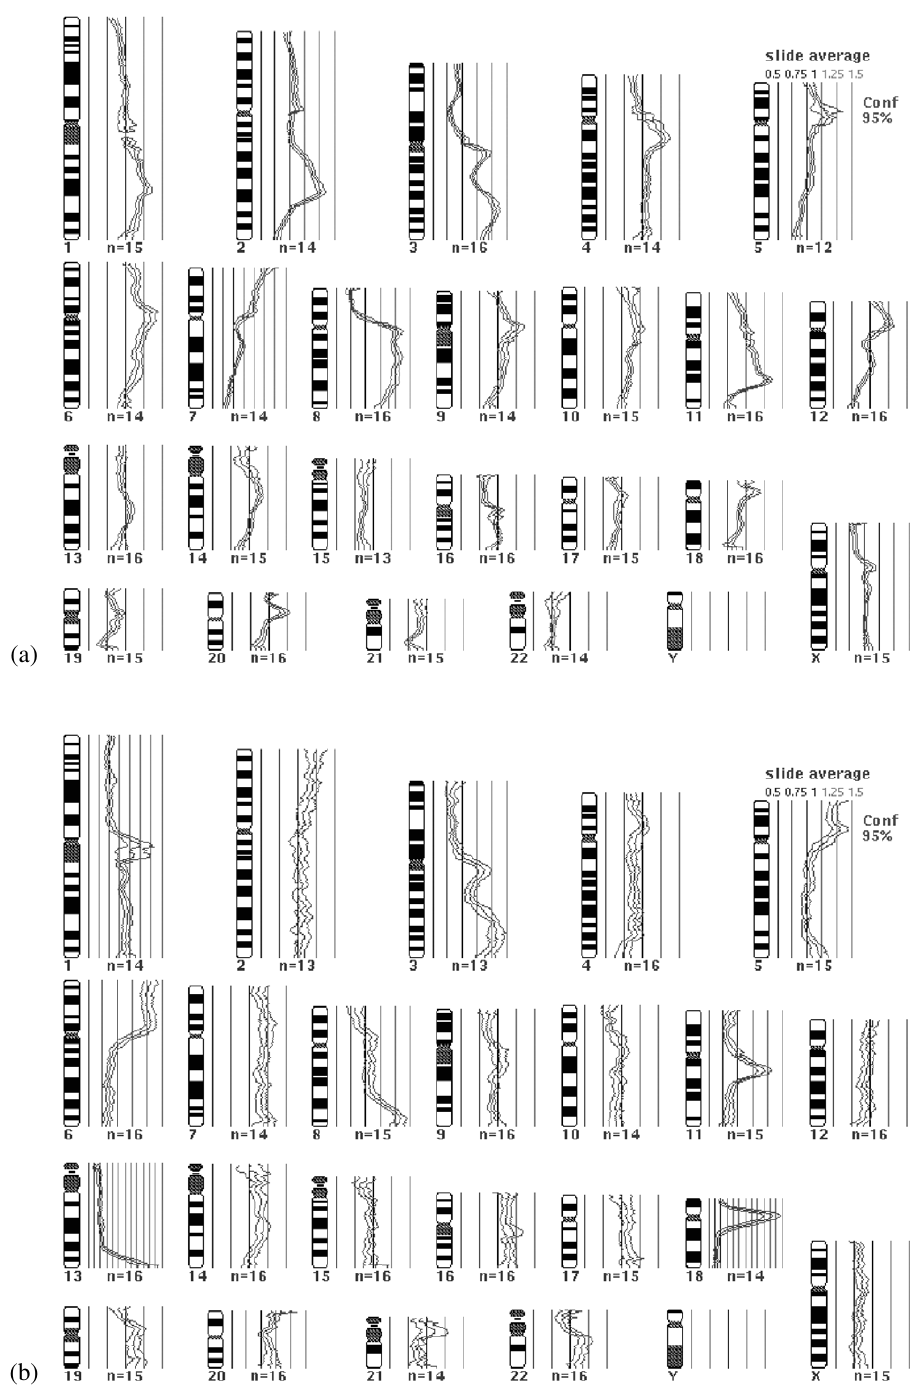
Fig. 1. (a) Example of a CGH result of a laryngeal squamous cell carcinoma with a diploid DNA histogram. Gains were found at 1q, 2p, 2q, 3q, 4q, 5p, 6p&q, 7p&q, 8q, 10p&q, 11q, 12p, 14q and 20p, and losses at 1p, 2q, 3p, 4p, 5q, 7q, 8p, 11p, 11q, 12q, 15q, 16p, 17p, 17q, 18q, 19p&q, 20q, 21q, 22q and Xp. (b) Example of a CGH result of a laryngeal squamous cell carcinoma with an aneuploid DNA histogram (DI = 1 . 55). Gains were found at 1q, 2p, 3q, 5p, 5q, 6p, 7p&q, 8q, 11q, 13q, 14q, 16p&q, 16q, 18q, 19q, 20p&q, and 22q, and losses at 3p, 4p, 4q, 5q, 6q, 8p, 9p, 10p, 11p, 11q, 18q, 21q and